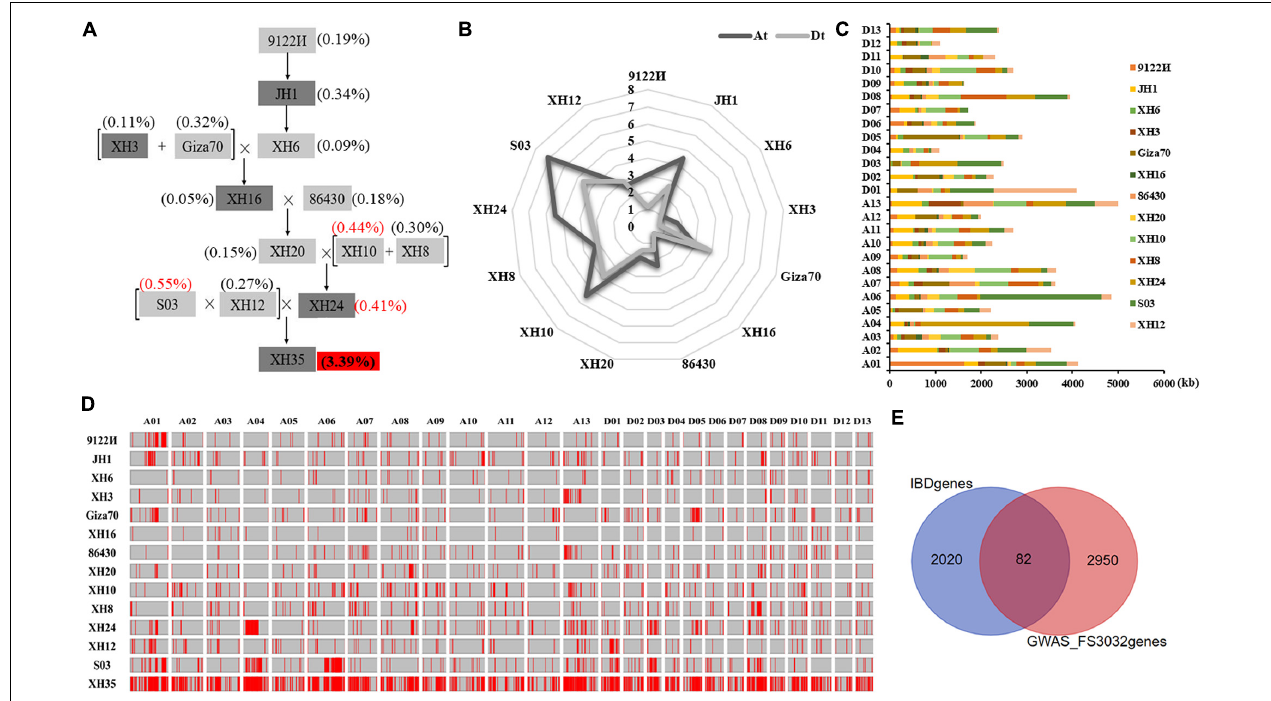
FIGURE 3 | Genetics underlying fiber strength improvement in XH35-bred pedigree. (A) XH35-bred pedigree, including 12 parental varieties. (B) Total length of genomic fragments inherited from 12 parents in the At and Dt subgenome. The length of genetic components in At and Dt is indicated in dark and light gray, respectively. (C) Length distribution of genomic fragments inherited from 12 parents on 26 chromosomes. (D) Homologous fragments of XH35 in 12 related parents from the pedigree [listed on the vertical axis (left)]. The horizontal axis (top) indicates different chromosomes. Unique genetic segments in each parent are specifically passed to XH60 according to the genetic pathway shown on (A) . (E) Venn diagram showing the overlapping FS genes (in middle garnet) obtained by genetic transmission analysis and GWAS